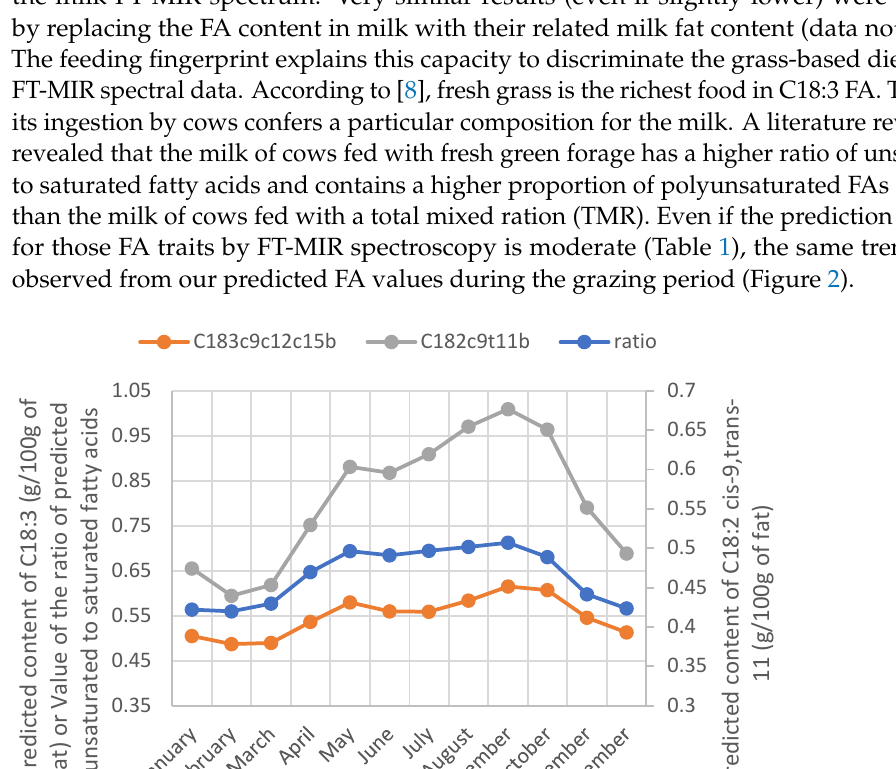
Figure 3. Yearly evolution of the predicted content of short-, medium-, and long-chain fatty acids in milk fat. The most informative traits were all related to the fat composition. Indeed, by de- creasing order of importance, the most informative markers were the predicted contents of C18:2 cis-9, cis-12, C16:0, C10:0, C6:0, and medium-chain FA in the milk (Figure 4). The fat content, which is the fraction of milk that varies the most during the passage to pasture [22], was also an important trait, even if it was not the most informative. The presence of short- and medium-chain FAs in the most informative predictors was expected, as those FAs are produced in the mammary gland during the de novo synthesis. The long-chain FAs are instead derived from the ingested feed [17]. The lower importance of polyunsatu- rated and long-chain FAs depicted in Figure 4 was therefore related to the strong opposite relationship existing between these groups of FAs. For example, C16:0, the second-most-